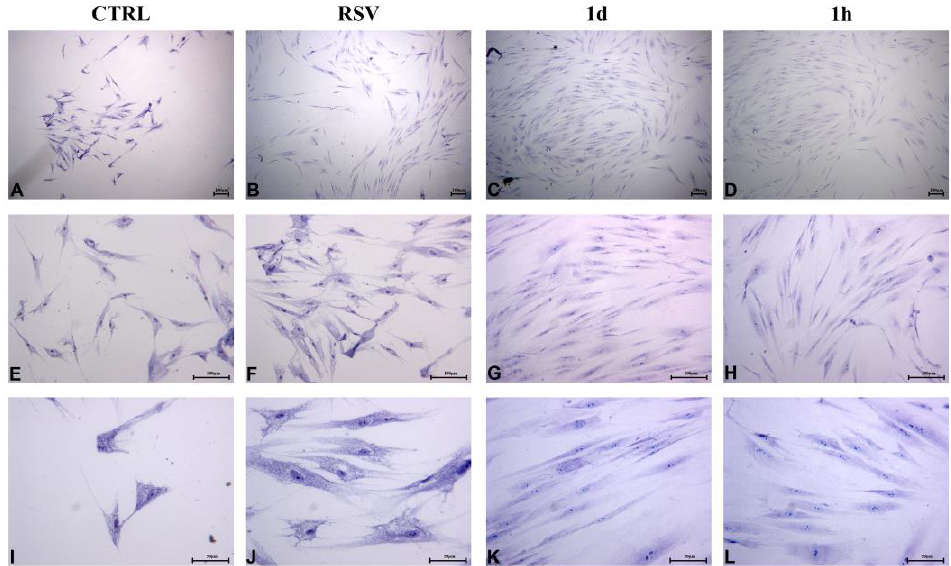
Figure 10. HGFs morphological and confluence analysis after the exposure to 1d and 1h for 72 h. Images were taken by an inverted microscope connected with a camera (Leica) at the magnifications of 40× ( A – D ), 100× ( E – H ), and 200× ( I – L ). (Scale bar: 100 µm for 40× and 100×; 50 µm for 200×).